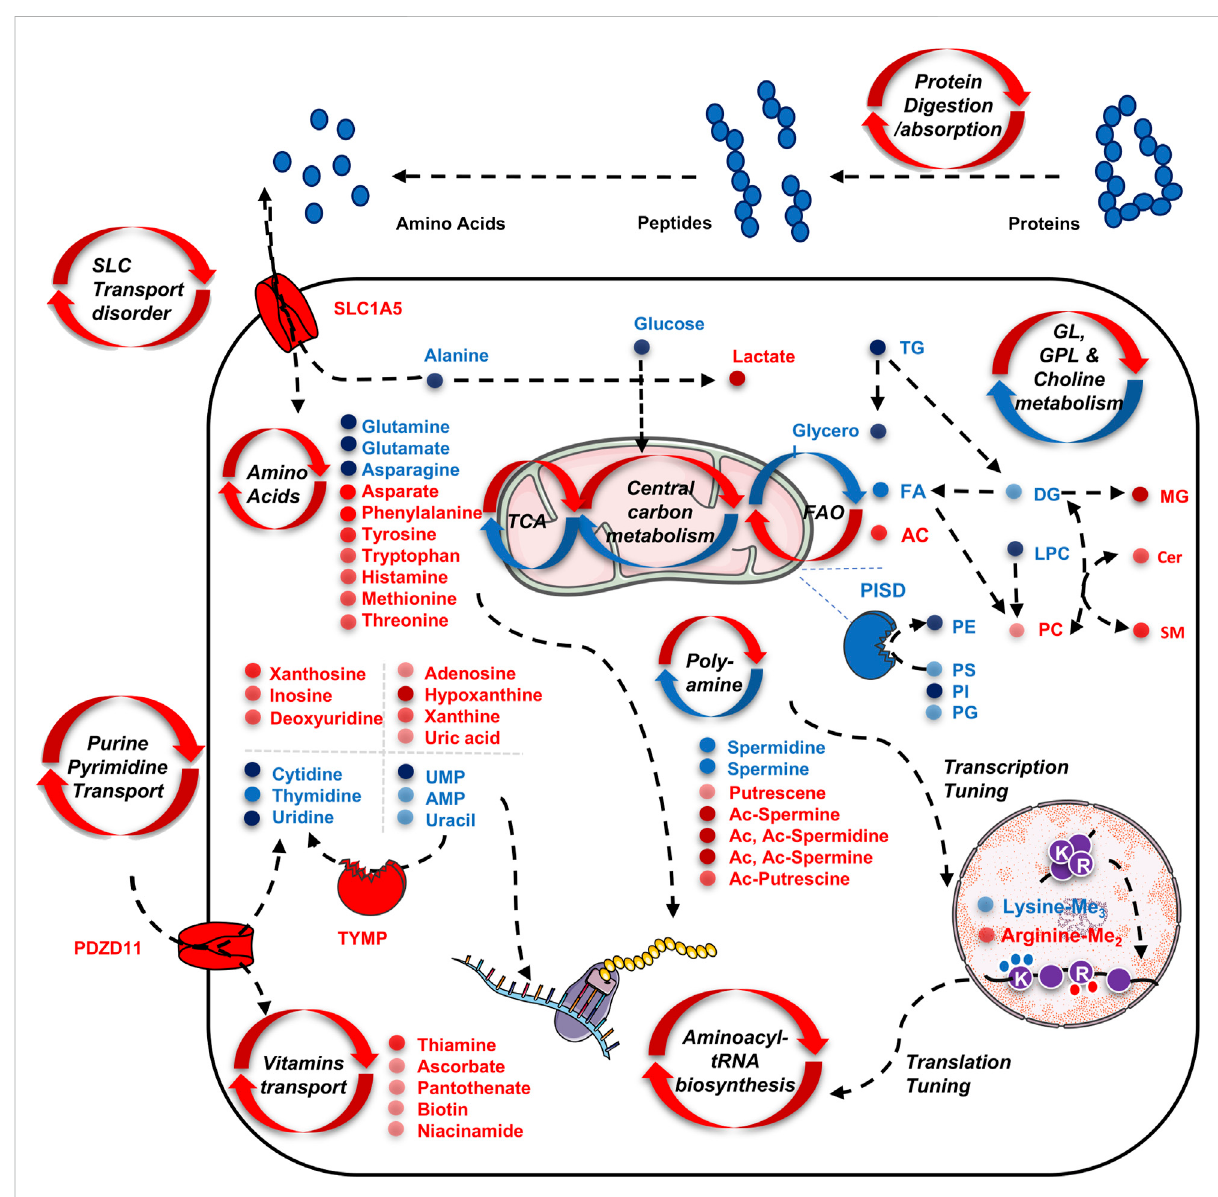
FIGURE 6 Schematic illustration of the up-regulated and down-regulated metabolites as well as their involved metabolism pathways for adapting the tumor cell ’ s proliferation and transcription regulation. All metabolites presented in the scheme are discovered by serum and tissue untargeted metabolomics analysis by the